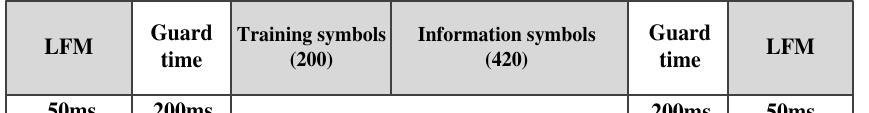
Figure 11. The frame format of DBPSK